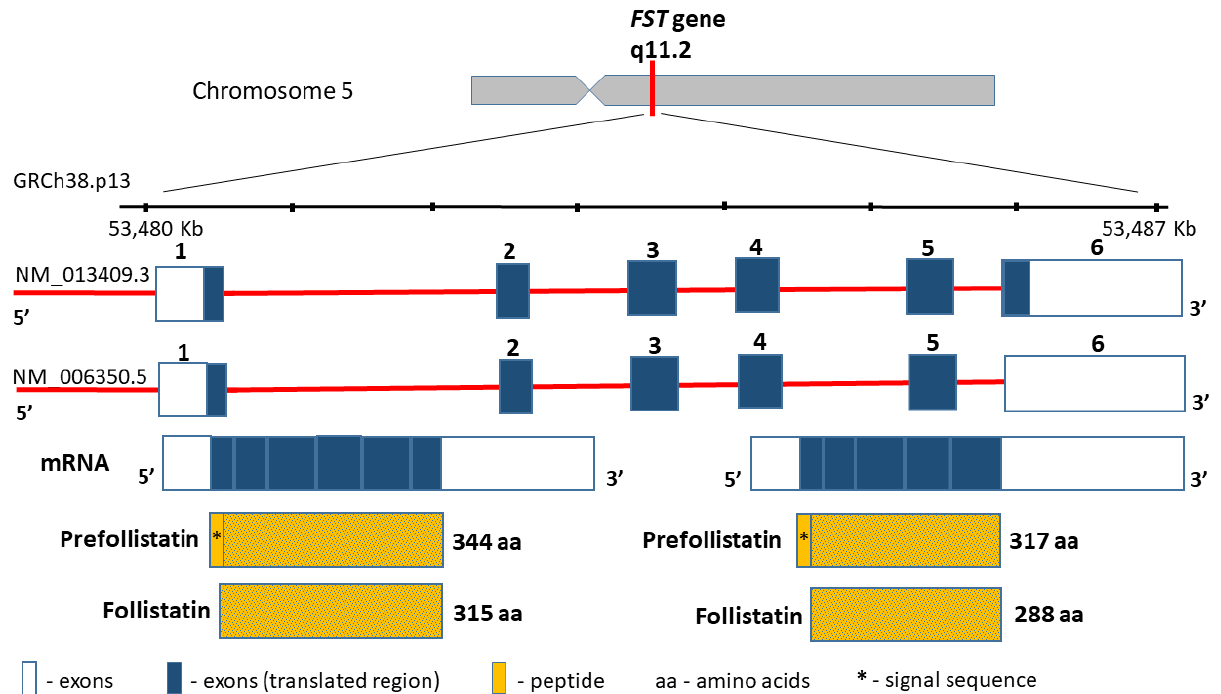
Figure 3. FST gene structure and protein product.